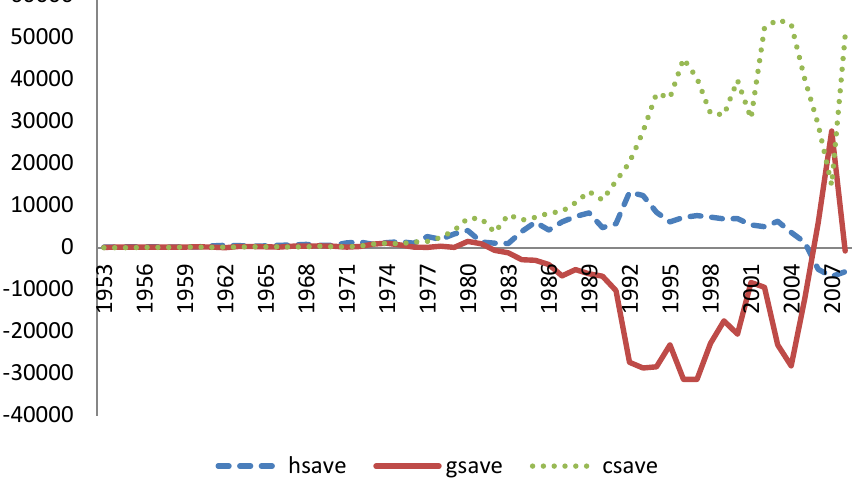
FIGURE 2: Share of Household, Government and Corporate savings in total savings (R millions)